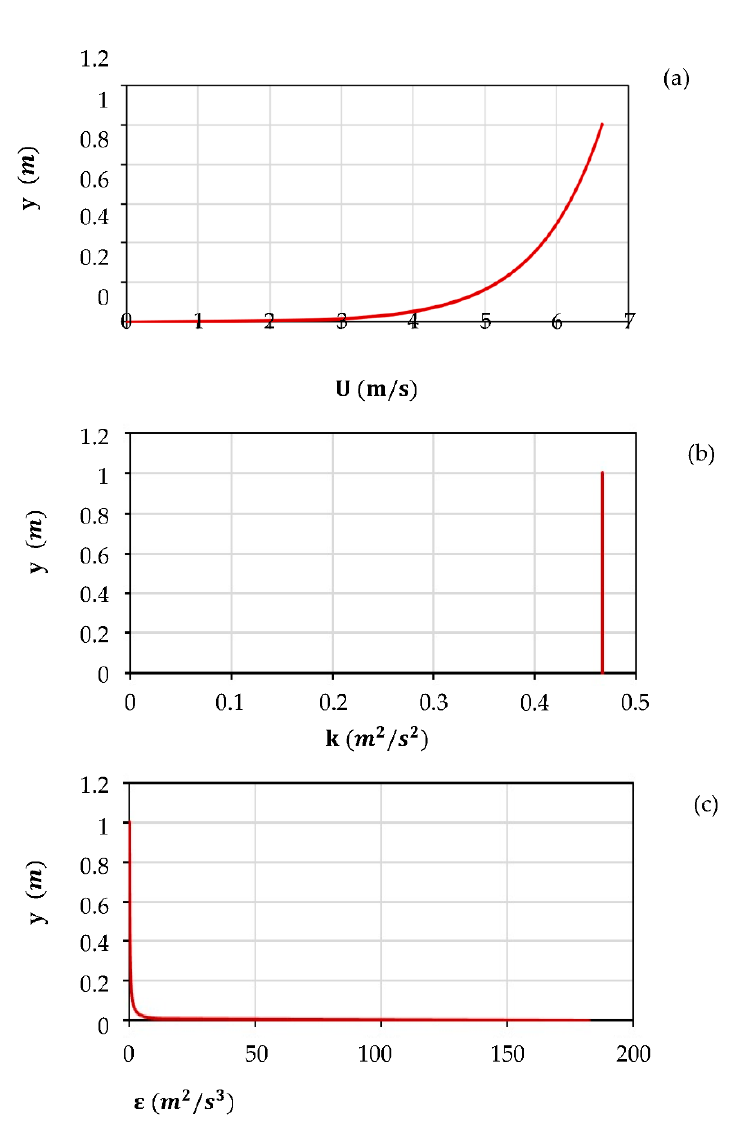
Figure A1. The analytical inflow conditions of ( a ) mean wind speed, ( b ) turbulence kinetic energy, k , and ( c ) turbulence dissipation rate, ε .